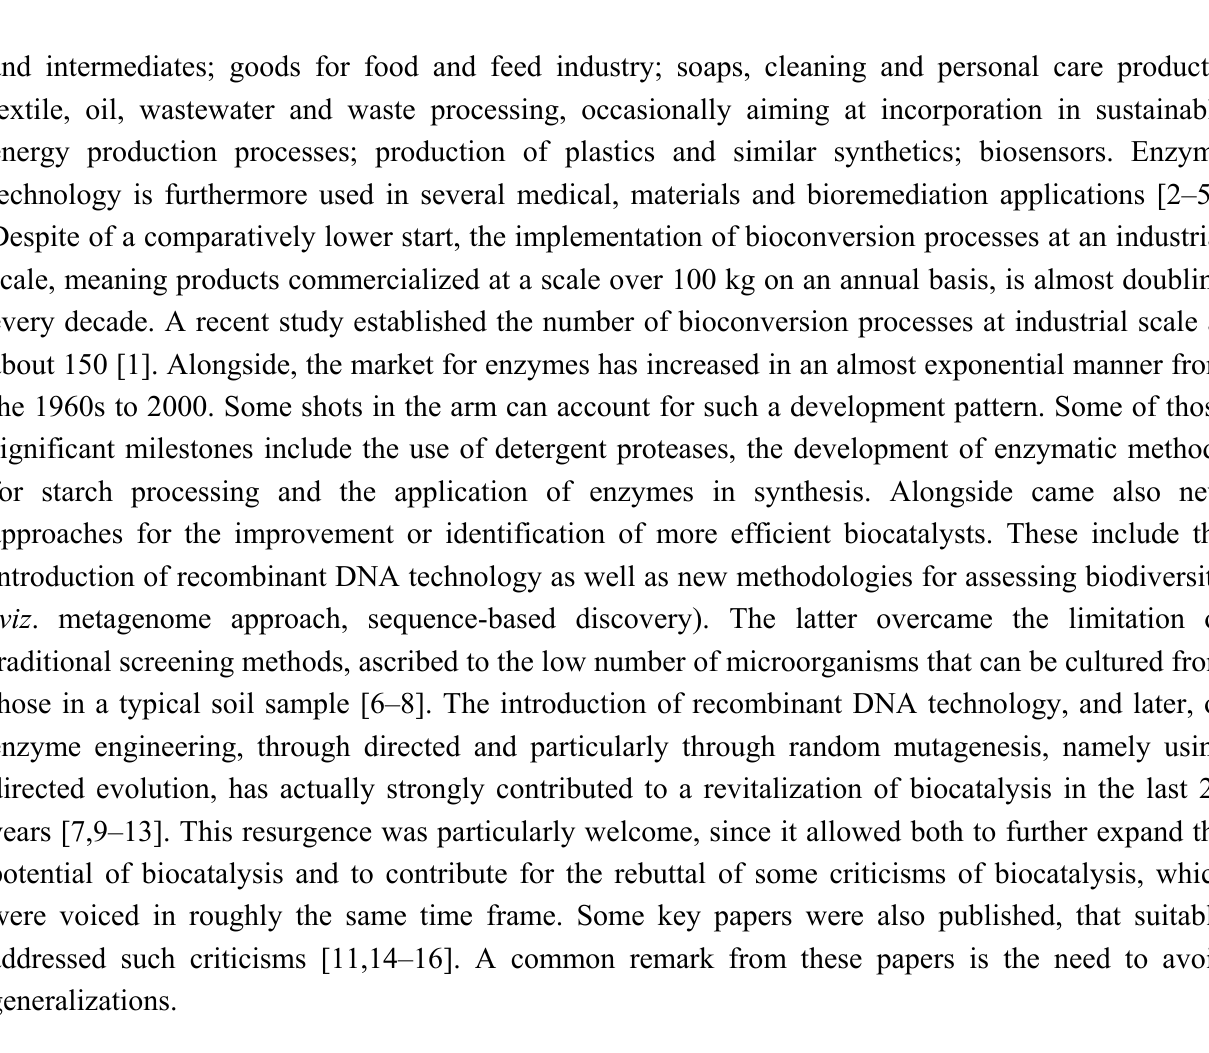
Table 1. Advantages, criticisms and comments on